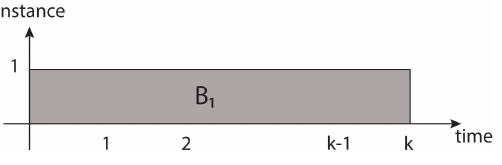
Figure 10. One block ( B 1 ) is used during a latency, which requires k clock